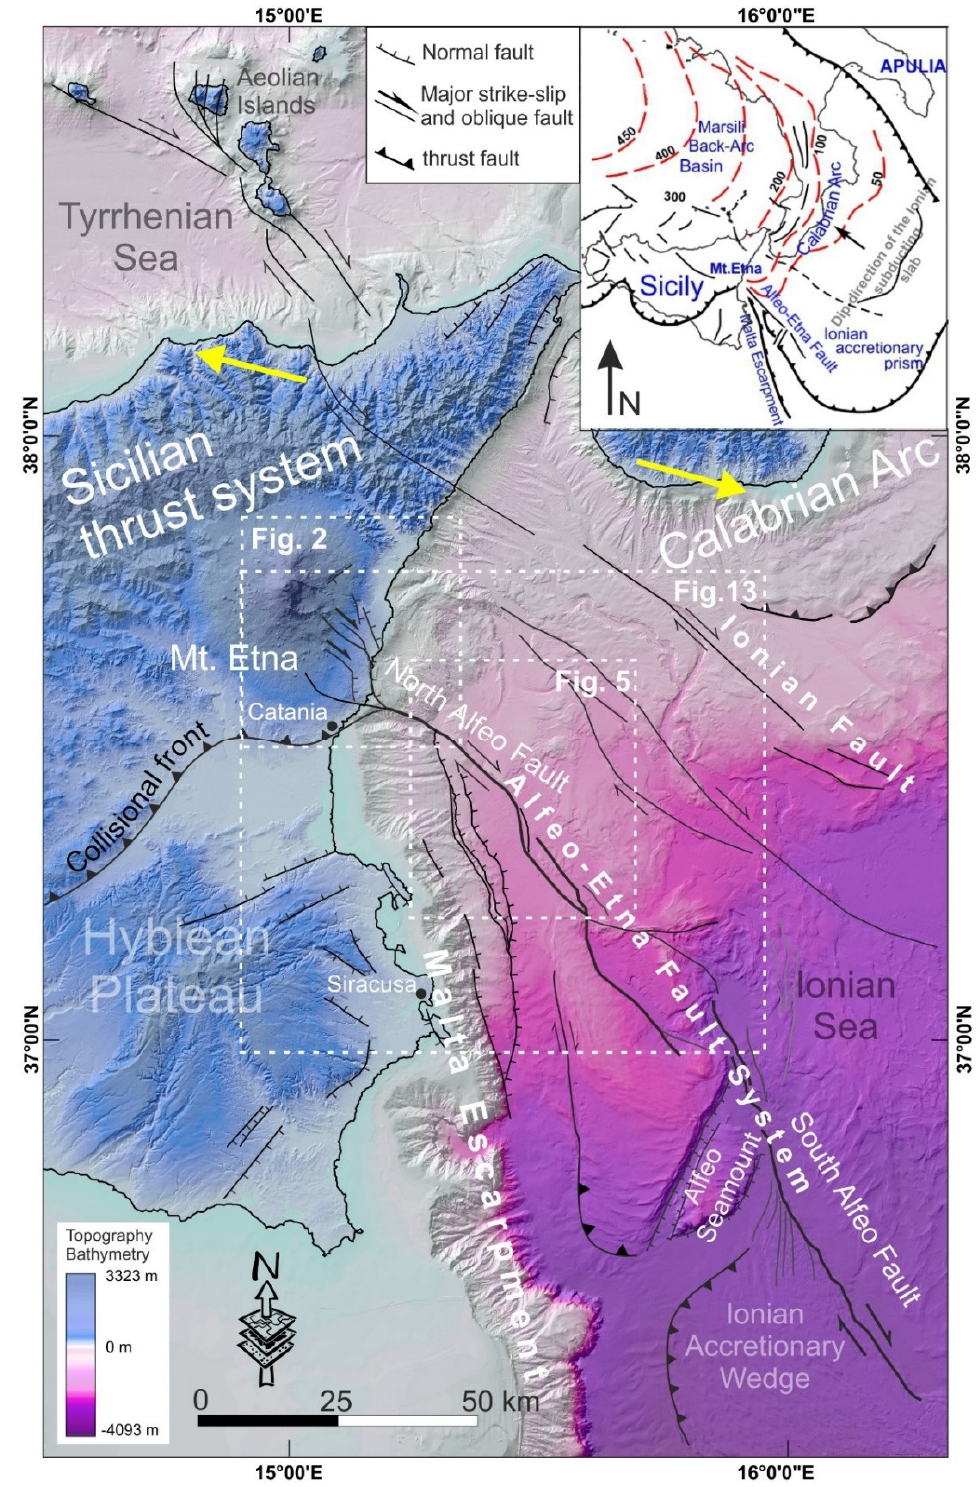
Figure 1. Tectonic sketch-map of eastern Sicily and the Ionian offshore (from [8] modified). The main tectonic features are from Polonia et al. [9] and Gutscher et al. [10]. Yellow arrows indicate the direction of geodetic extension between Sicily and the Calabria–Ionian sector (from Palano et al. [11]; De Guidi et al. [12]; D’Agostino and Selvaggi [13]; Serpelloni et al. [14]). Inset shows the location of Mt. Etna in the geodynamic framework of the eastern Mediterranean, at the southern edge of the subducting Ionian slab (dashed lines with numbers indicate its depth in km).